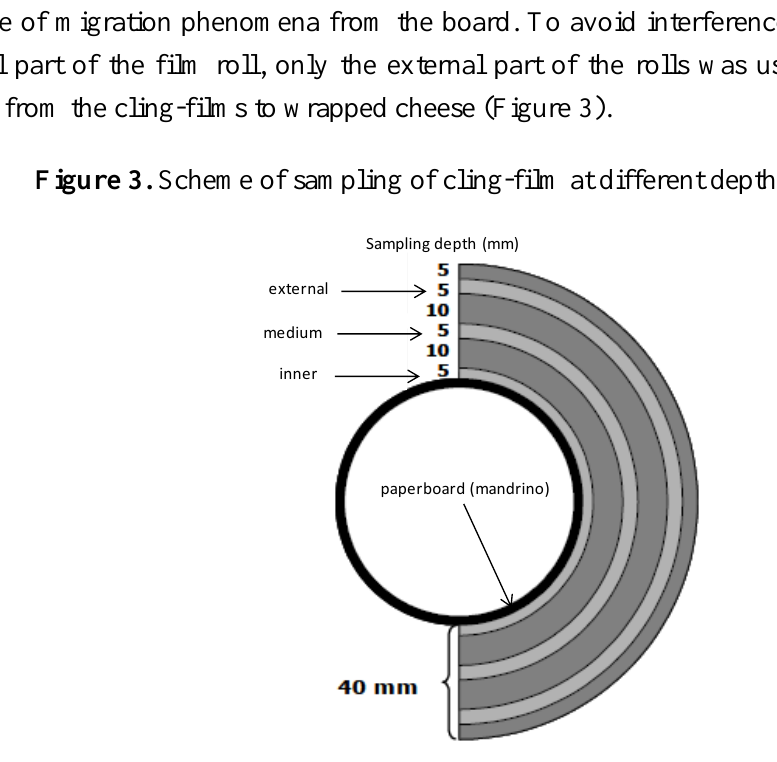
Figure 4. Terpenes, esters and aldehydes content in different sections of rolls (µg g −1